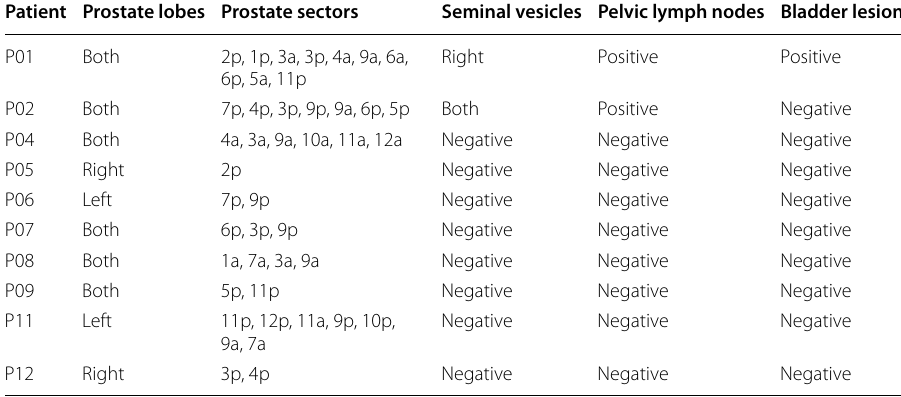
Table 4 Pre-surgery PSMA PET/CT prostate lesions localization, seminal vesicles, bladder and pelvic lymph nodes involvement Patient Prostate lobes Prostate sectors